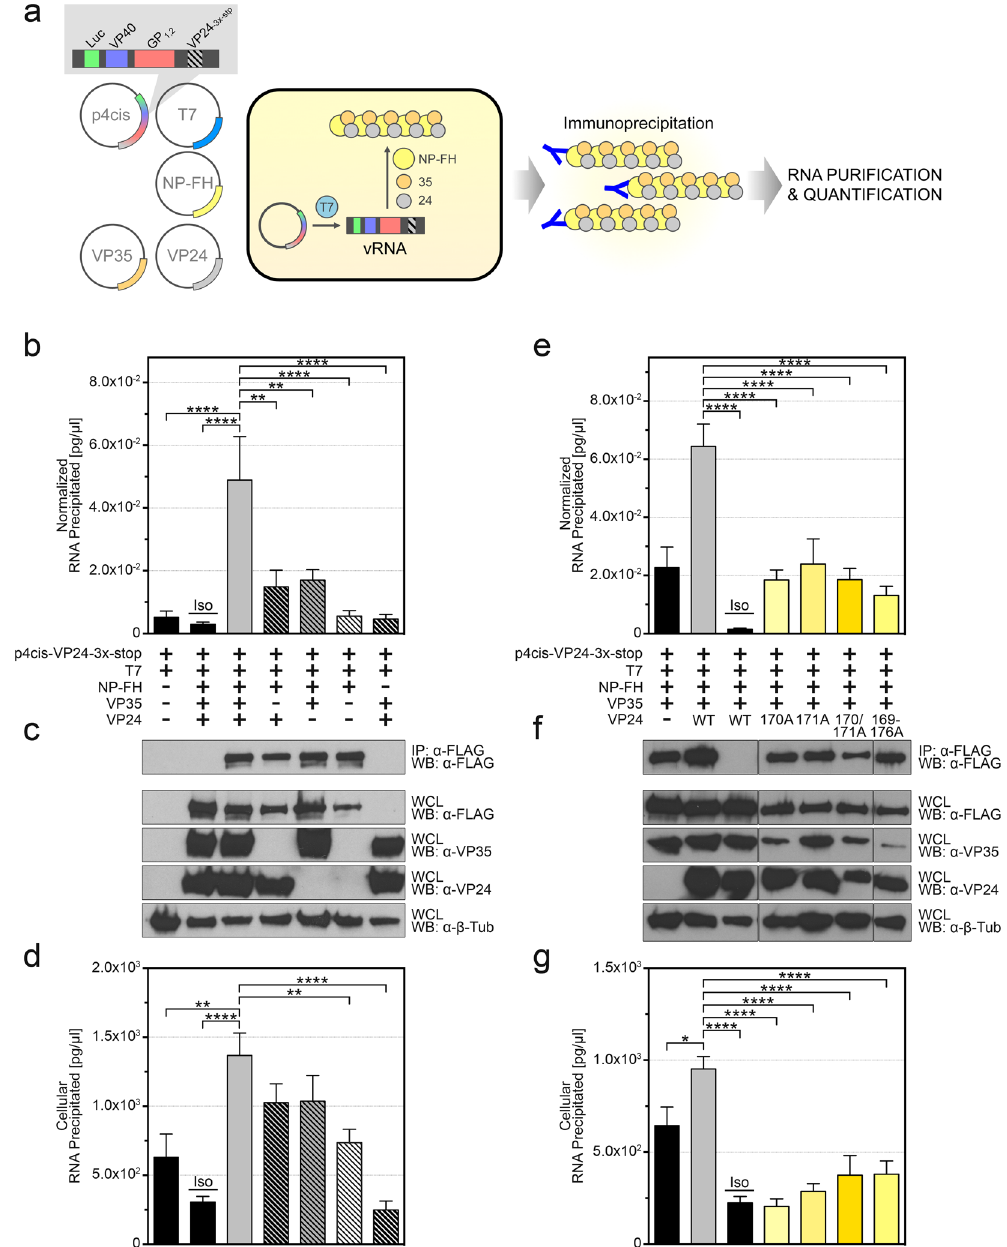
Figure 5. VP24 is critical for EBOV genome encapsidation. ( a ) A schematic of the EBOV RNA immunoprecipitation assay. Transcription of the tetracistronic minigenome (p4cis), encoding VP24-3x-stop, by the T7 polymerase produces viral RNA (vRNA) template that can be encapsidated by NP with a C-terminal FLAG/HA tag (NP-FH), VP35, and VP24, supplied in trans . ( b – g ) HEK 293 cells were co-transfected with p4cis- vRNA-RLuc (p4cis), encoding VP24-3x-stop, as well as pCAGGS-T7, pCAGGS-NP-FH, pCAGGS-VP35, and wild-type (WT) pCAGGS-VP24 ( b – d ) or a VP24 mutant: pCAGGS-VP24 V170A, pCAGGS-VP24 N171A, pCAGGS-VP24 V170/N171A, or pCAGGS-VP24 169–176A ( e – g ). Lysates were immunoprecipitated with mouse anti-FLAG or an isotype control (Iso) antibody, and RNA was purified and then quantified via RT-qPCR. The total concentration in pg/ul of EBOV minigenome RNA precipitated was normalized against the total concentration of EBOV minigenome RNA in whole cell lysates for each transfection ( b , e ). Immunoprecipitation (IP) and whole cell lysate (WCL) fractions were subjected to Western Blot (WB) with mouse anti-FLAG, mouse anti-VP35, rabbit anti-VP24, or rabbit anti- β -tubulin antibodies ( c , f ). Western blots were cropped for presentation; full-length blots are available in Supplementary Fig. 9. The total concentration in pg/ul of cellular RNA in IP fractions was quantified using a Low Abundance RNA Quantification kit ( d , g ). The means and standard error of the mean for 8 ( b ) and 6 ( e ) independent experiments are shown, with the exception of the minigenome/T7-only control, for which 7 ( b ) independent experiments are shown ( ** p ≤ 0.01; **** p ≤